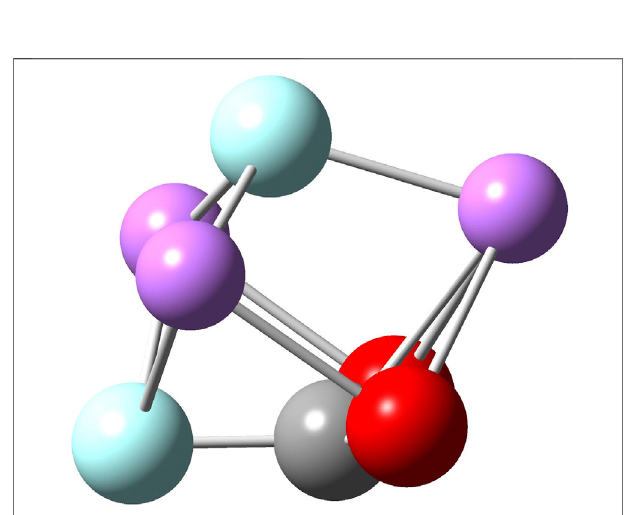
FIGURE 6 | B3LYP/6-31G* optimized geometry of the Li 3 F 2. CO 2 complex inside C 60 .